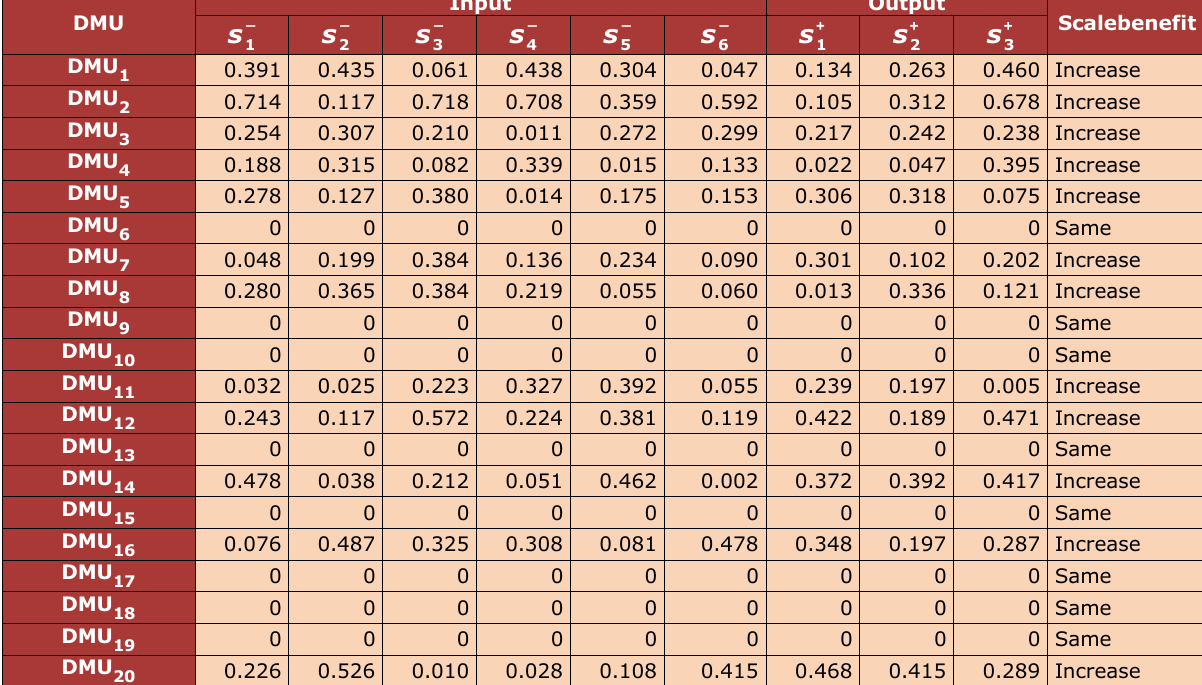
Table 3. Slack variable of input and output indexes in